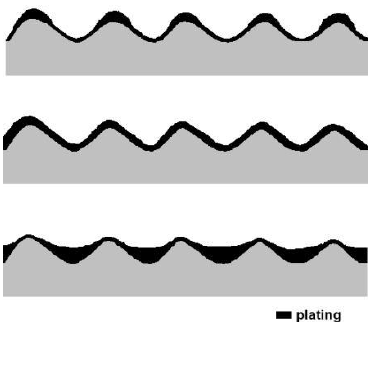
Figure 27. Schematic illustration of various micro throwing characteristics of electroplating  32  .